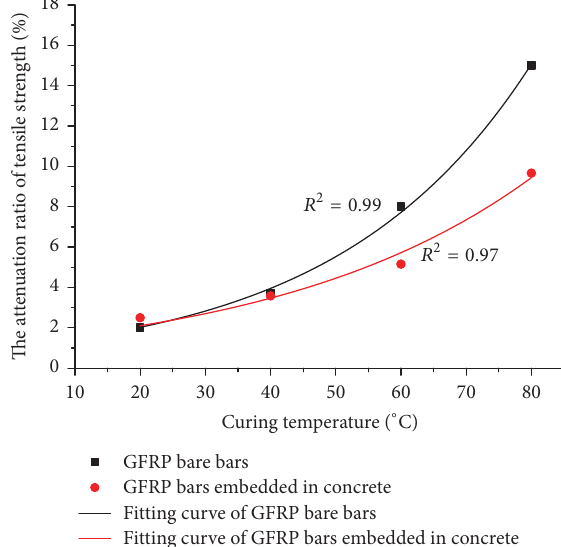
Figure 6: FTIR spectra for C-Sta and C-Ste60 samples.